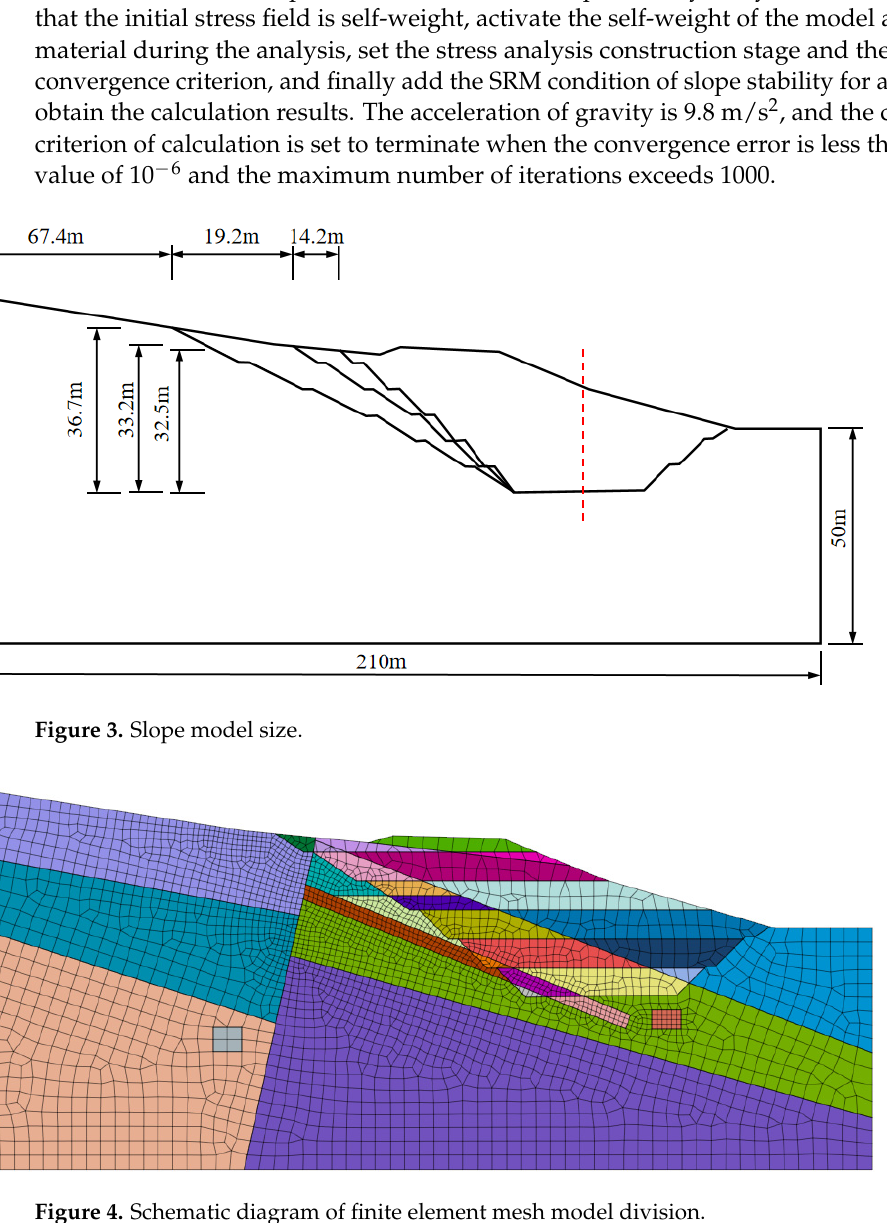
Figure 4. Schematic diagram of finite element mesh model division.